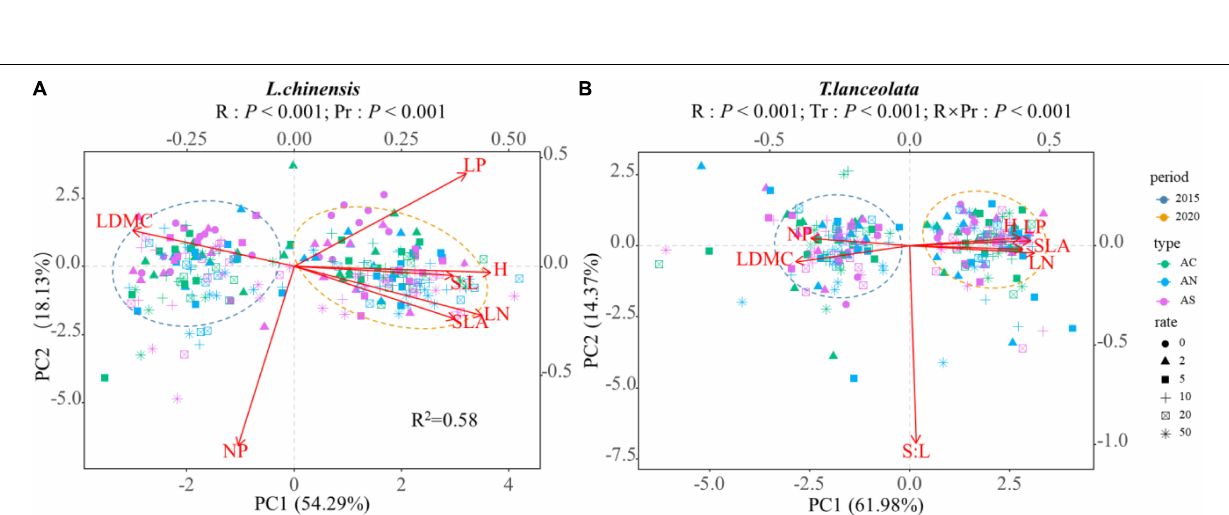
Frontiers in Plant Science |